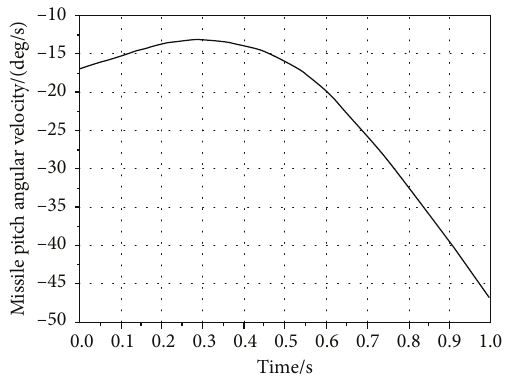
Figure 21: Pitch angular velocity curve.